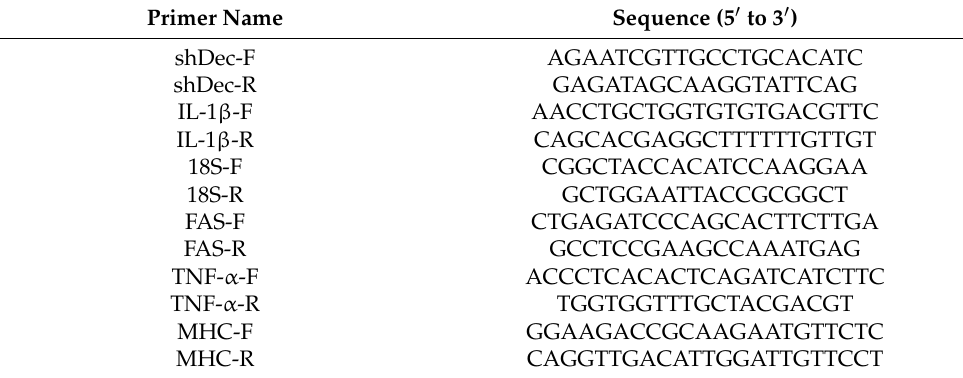
Table 1. Information of primers